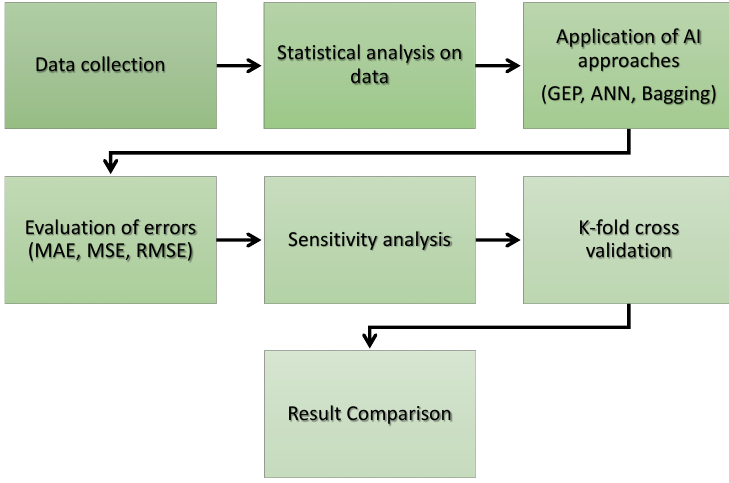
Figure 3. Flow chart of the research program.